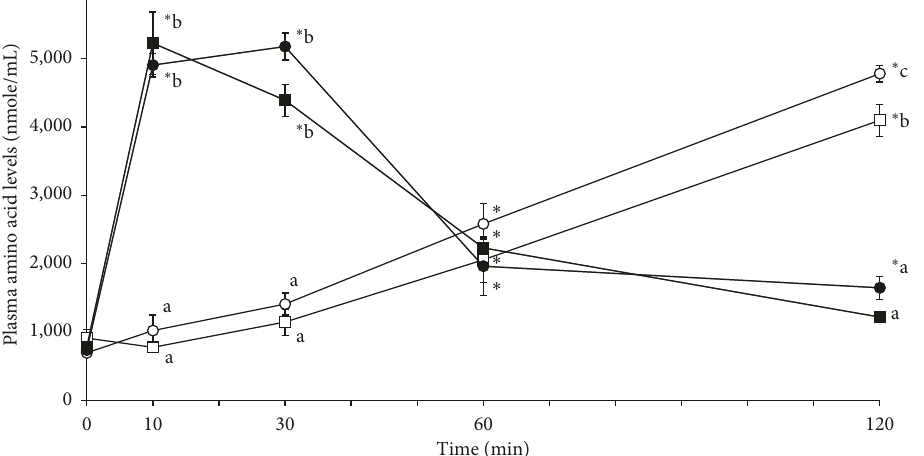
Figure 1: Changes in plasma amino acid levels in portal vein cannulated rats: the rate of amino acid absorption in portal vein cannulated rats administered milk whey protein, milk whey hydrolysate, egg white protein, or egg white hydrolysate. □ : milk whey protein; ■ : milk whey hydrolysate; 〇 : egg white protein; • : egg white hydrolysate. Data are mean ± SE of 6 rats. Different letters show significant difference at p < 0 . 05 by Tukey’s test. ∗ p < 0.05 vs. 0 minutes by the Dunnett test. Table 2: Growth variables in rats fed a diet containing protein or hydrolysate of milk whey or egg white. Milk whey Egg white Protein